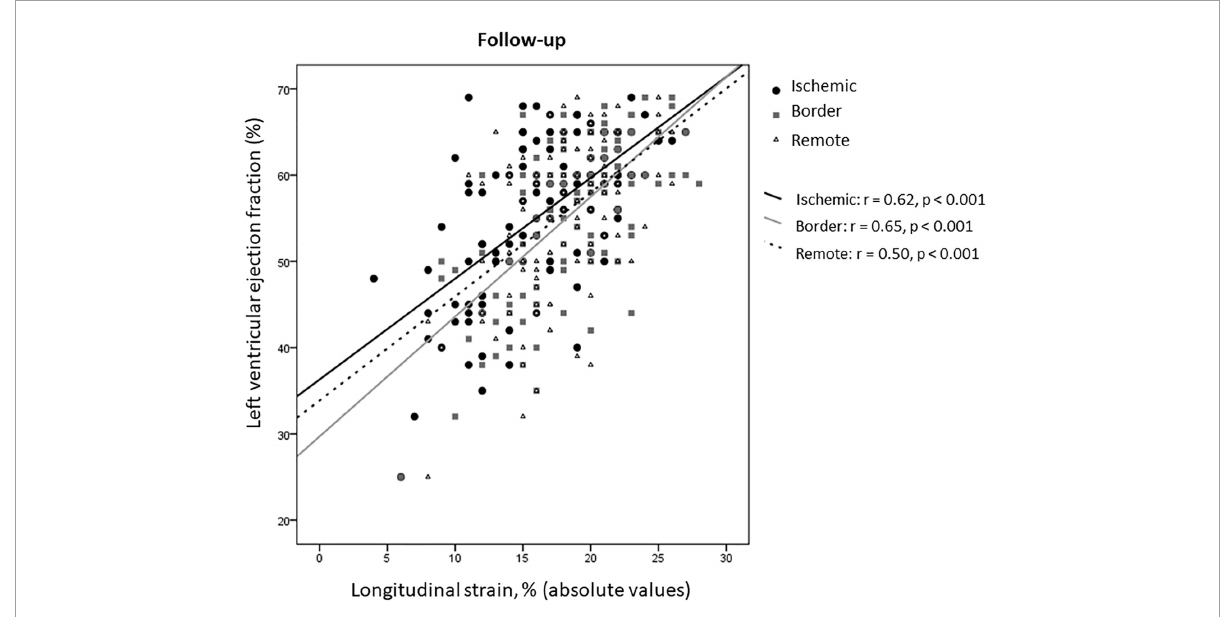
FIGURE4 Correlations between LS of ischemic, border, and remote myocardium and LVEF at